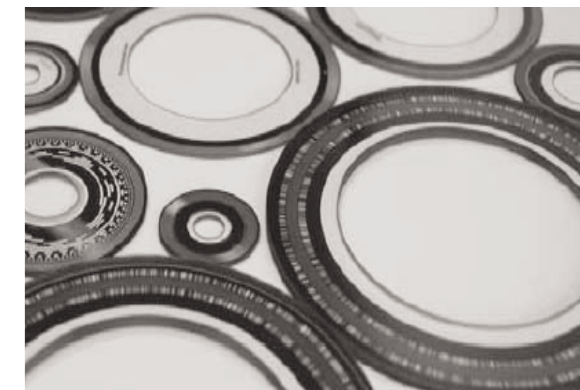
Fig. 2. Real examples of circular scales